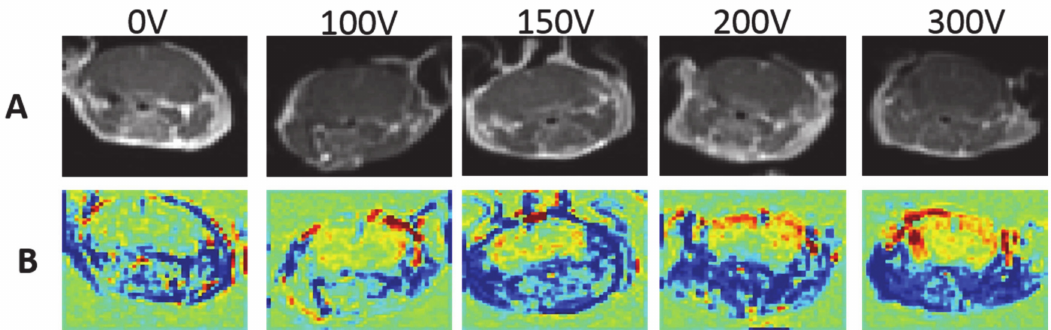
Figure 4. Examples of T1-MRIs and their equivalent 30 min TRAMs for different treatment voltages. ( A ) T1-MRI obtained immediately post-contrast injection for sham (0 V) and for mice treated with 100 pulses at 100–300 V. No enhancement is visible in the brain parenchyma ( B ). TRAMs calculated by subtracting the first T1-MRI post-contrast injection from the 30 min T1-MRI, showing increased BBBd volumes (depicted yellow/red, mainly in the cortex) with increased treatment voltage.